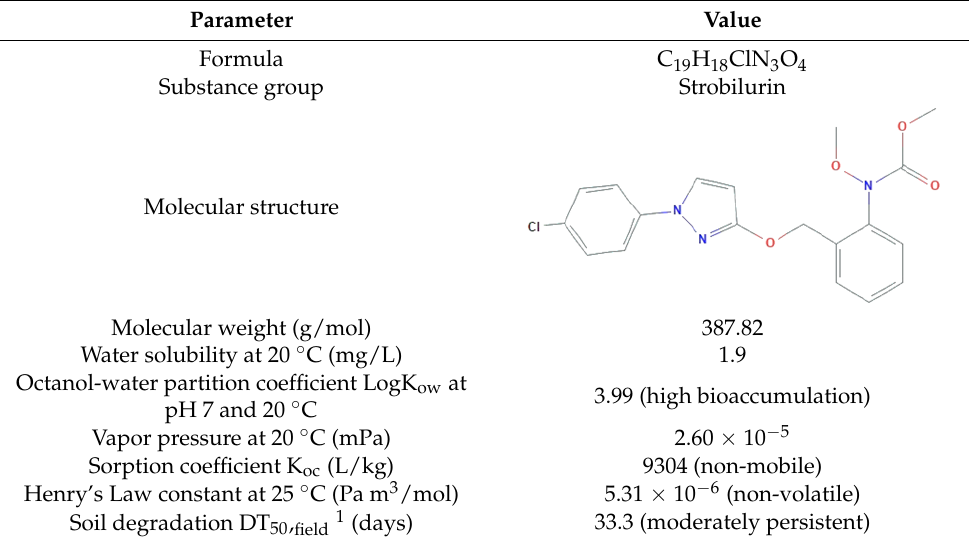
Table 1. Pyraclostrobin properties.